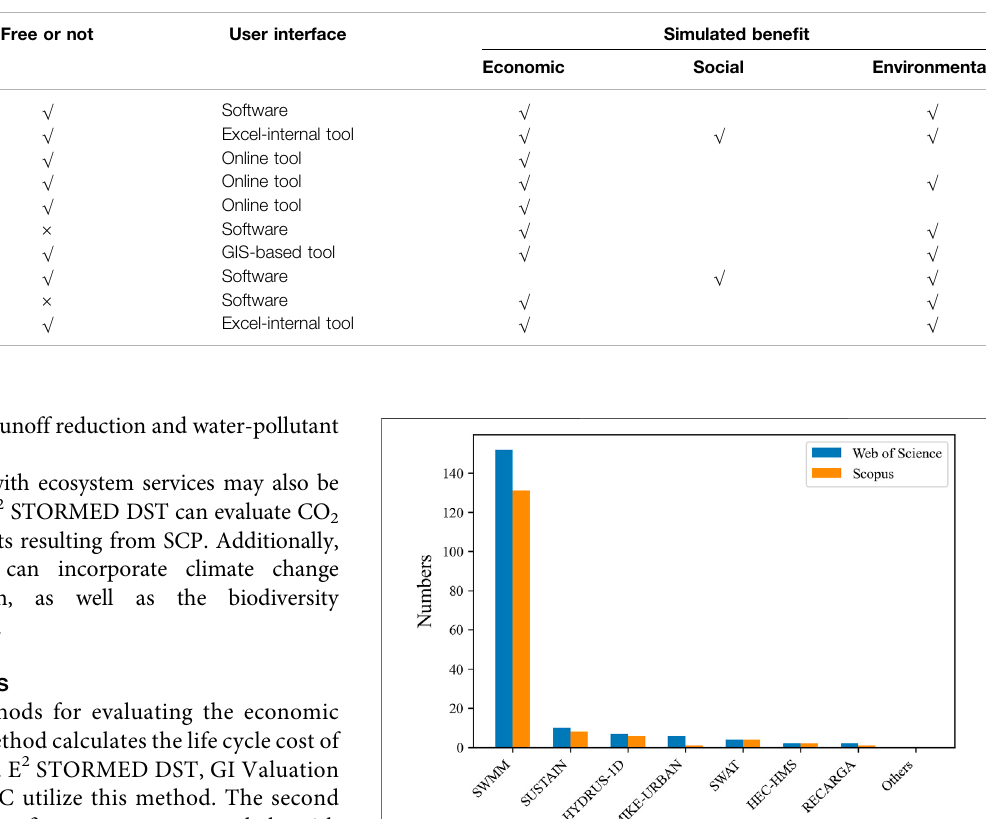
TABLE 2 | Comparison of DSTs.